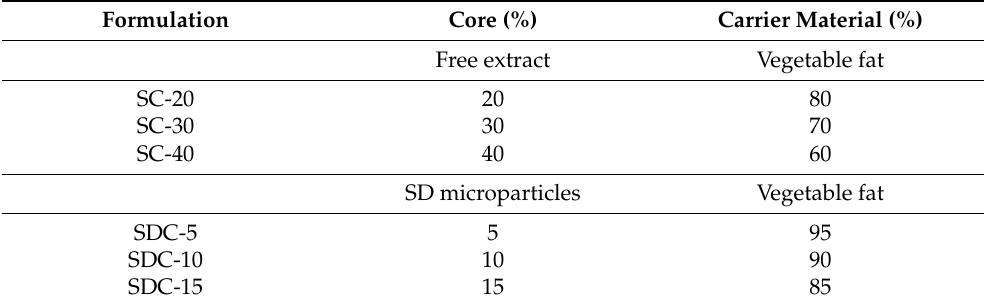
Table 5. Description of the components used in the production of